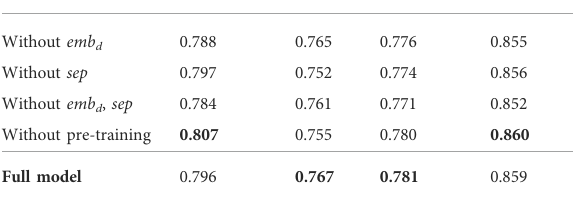
TABLE 3 Precision, recall, F1 score, and accuracy of the ablation